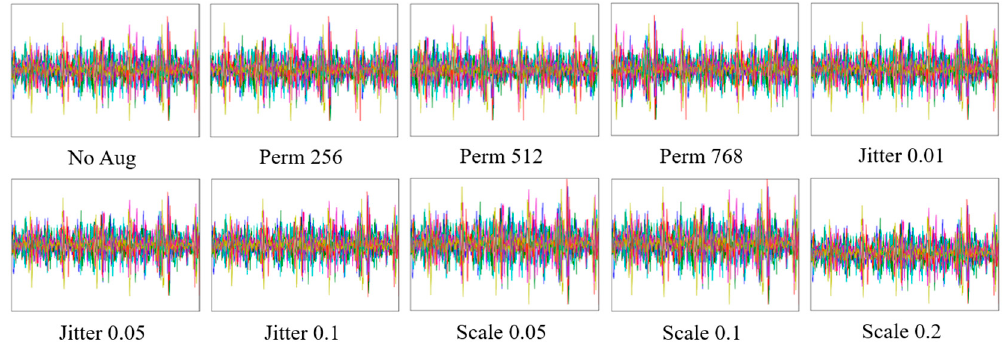
Figure 6. Data augmentation consisting of permutation, jittering, and scaling.